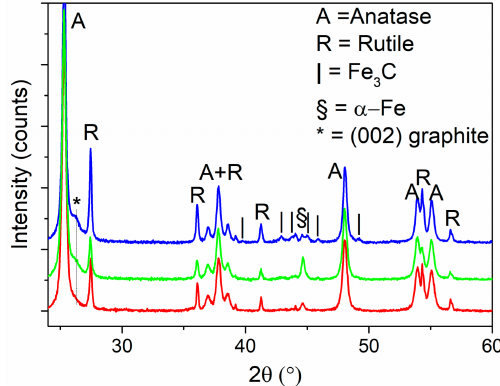
Figure 4. XRD patterns after thermal decomposition of C 2 H 4 at 750 ◦ C for 1 (cid:48) of Fe-titanate